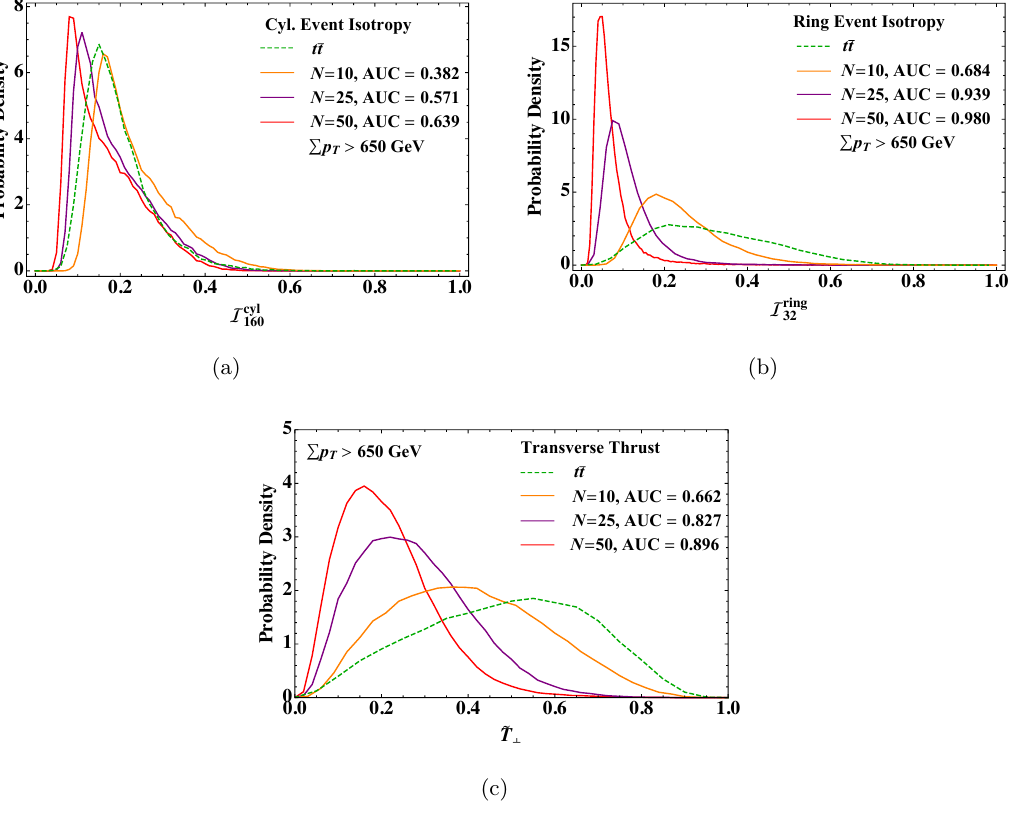
Figure 16 . The same as (cid:12)gure 15, but now compared to the t (cid:22) t